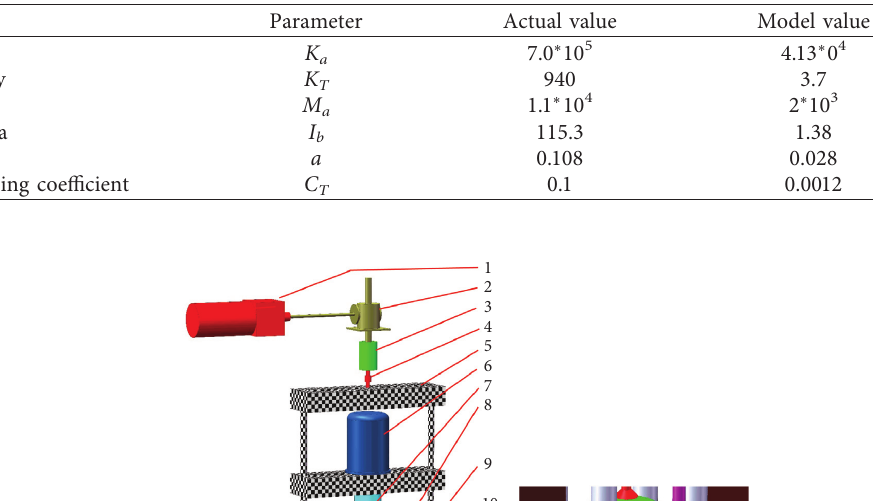
Table 3: Model scale parameters for the experimental model.